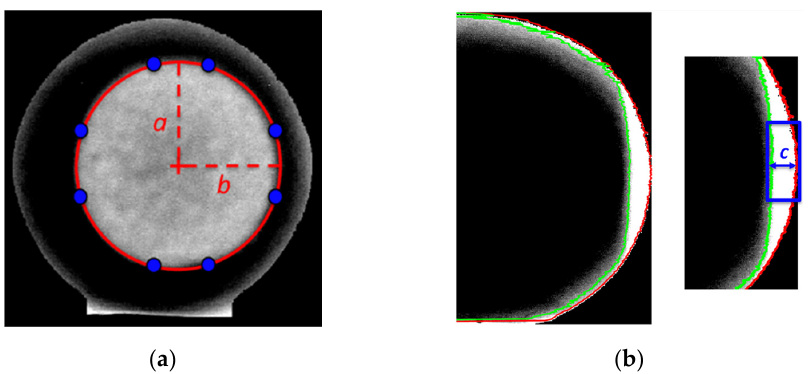
Figure 8. ( a ) Fitted ellipse and estimated semi-axis sizes ( a , b ) using eight data points (front view) and ( b ) external and internal profiles used for estimation of the air chamber height ( c ).